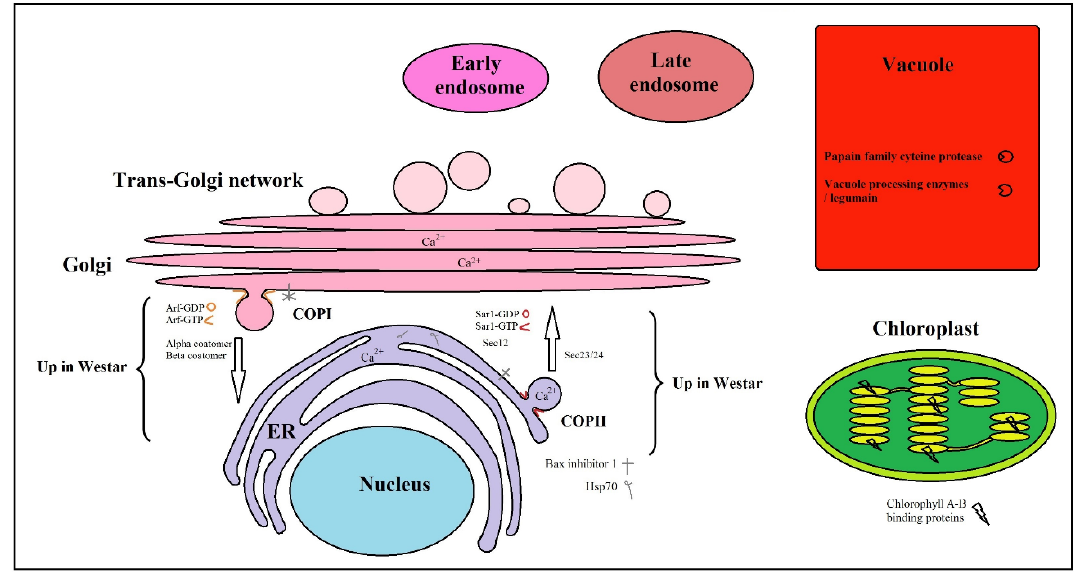
Figure 10. A proposed model on how some of the most highly-expressed DEGs (differentially expressed genes) might interact, potentially resulting in programed cell death. ER: Endoplasmic reticulum.